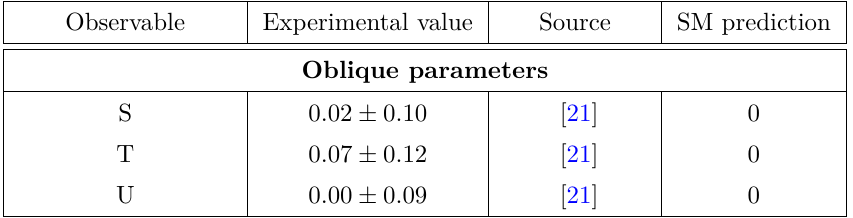
Table 5. List of the Oblique parameters used in the analysis in section